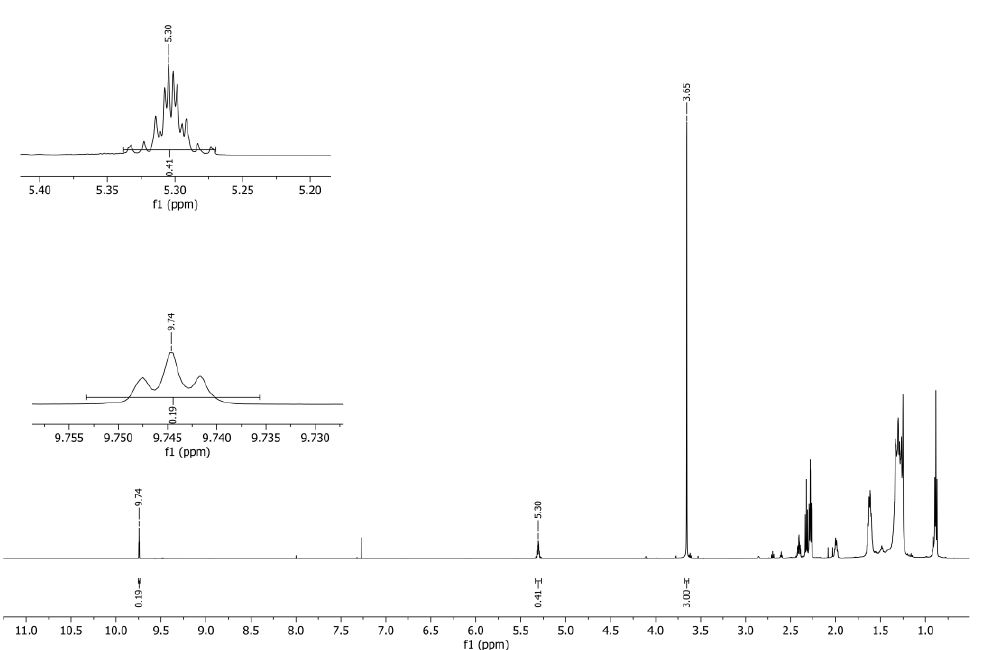
Figure 13. 1 H NMR spectrum for oxidized canola FAME product.